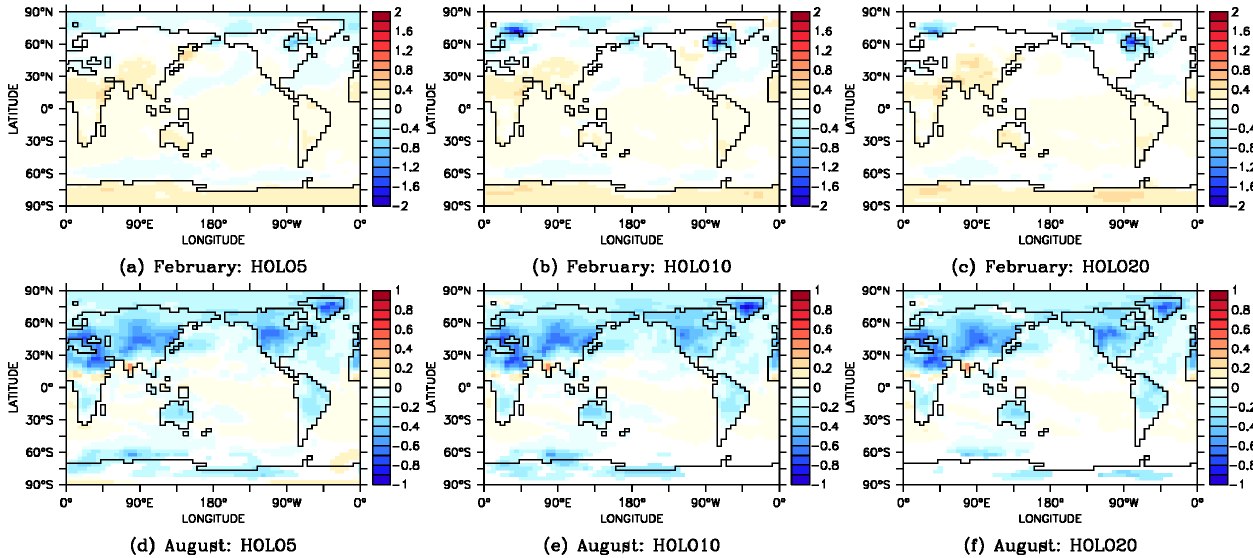
Fig. 9. The linear trend in surface air temperature (K per 1000yr) during the late Holocene: (a–c) February, experiments HOLO5, HOLO10 and HOLO20, respectively, and (d–f) August, experiments HOLO5, HOLO10 and HOLO20, respectively. Only values that are significant at the 95% confidence level are shown. Note the different scale bars for the February and August plots.